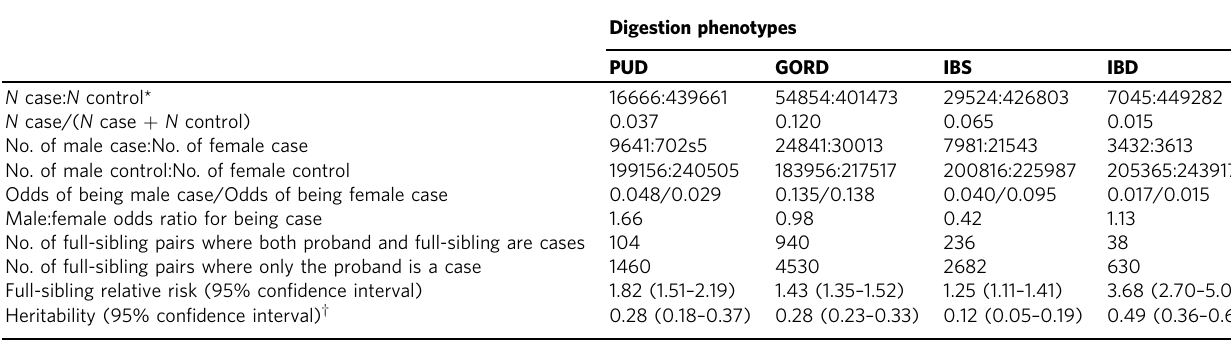
Table 1 Full-sibling relative risk and heritability estimation for PUD, GORD, IBS, and